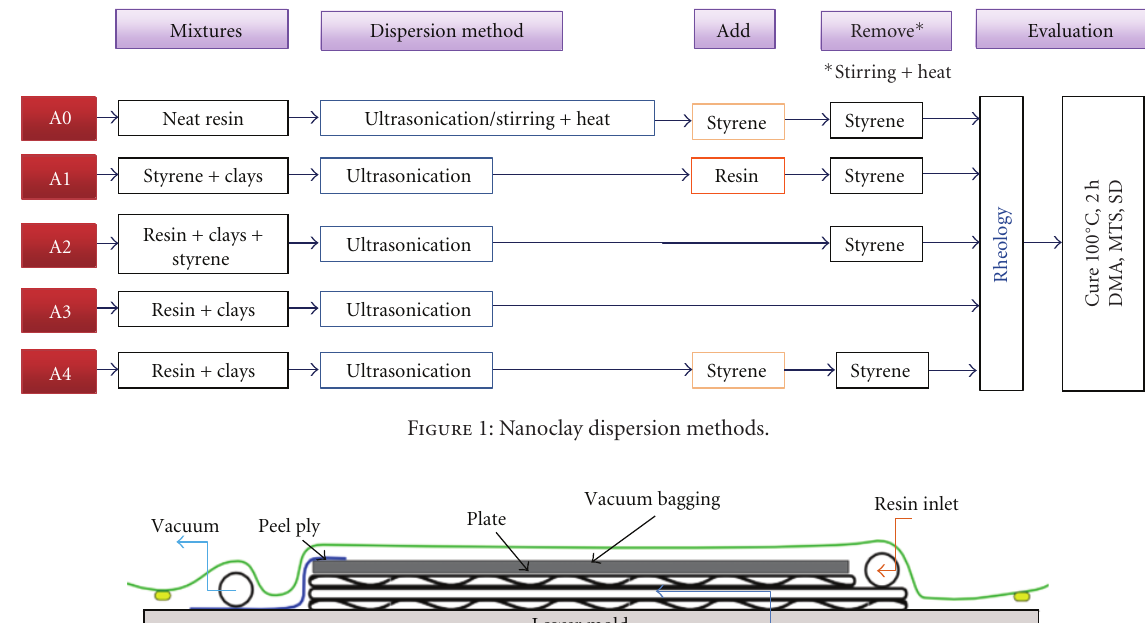
Figure 2: SCRIMP composite manufacturing setup. The liquid resin infusion was performed throug a classical VARTM process. The aluminum plate on top reduce thickness variation of the part. The reinforcement is a combination of oriented fibers and